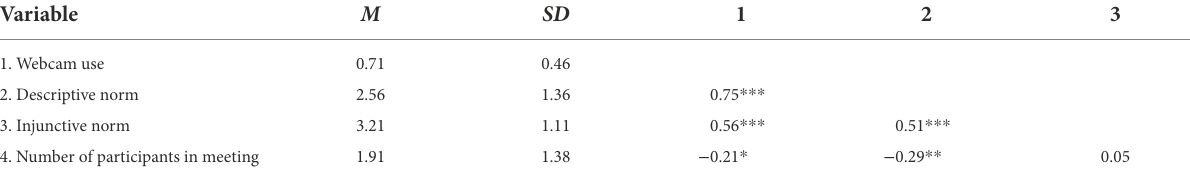
TABLE 2 Means, standard deviations, and correlations in the professional